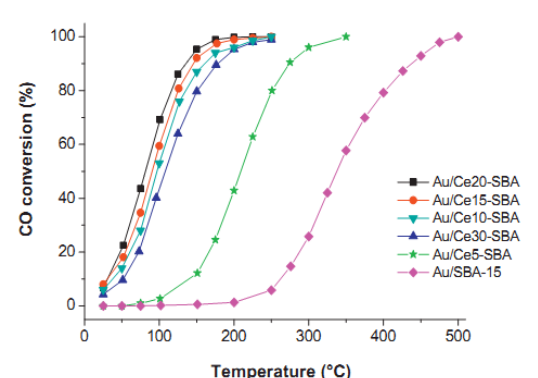
Figure 3. CO conversion (%) to CO catalysts (1 vol% CO + 1 vol% O permission from [27]. Copyright 2012 Elsevier